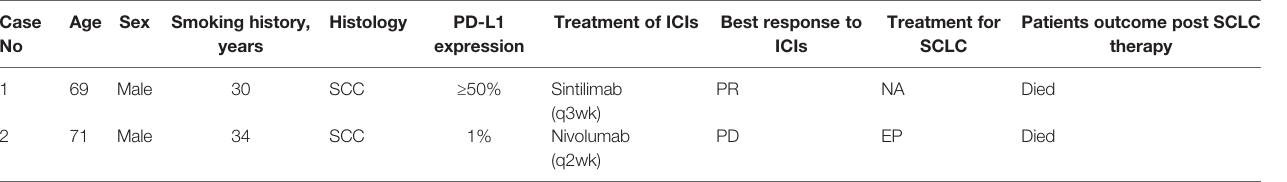
TABLE 1 | Summary of clinicopathological characteristics of the two cases.